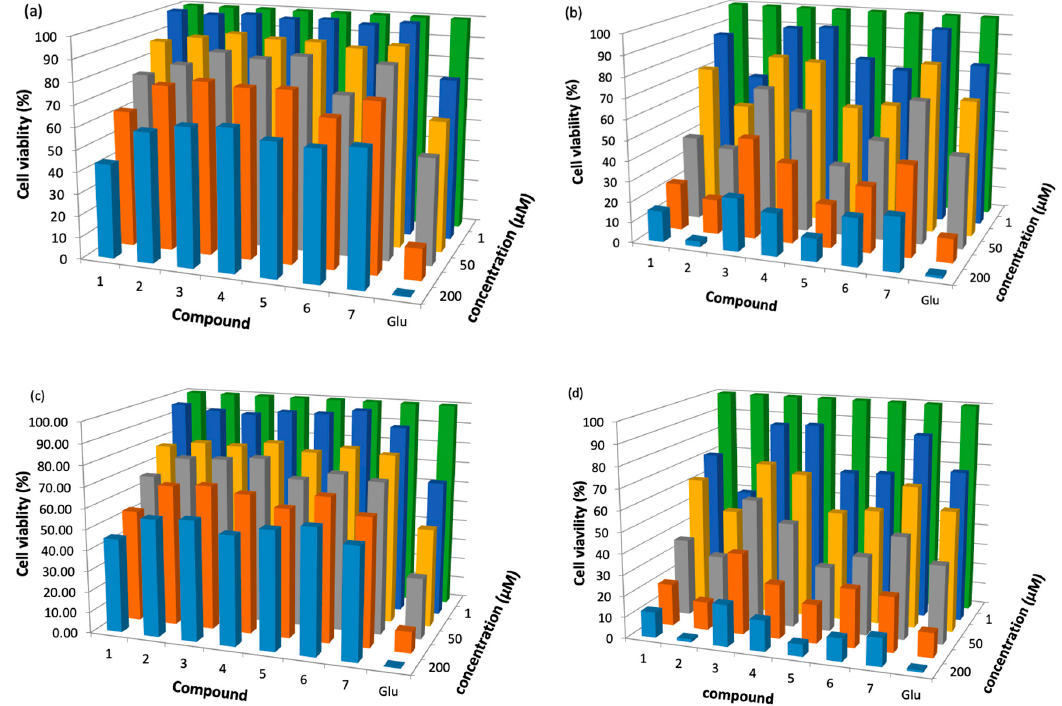
Figure 1. Parasite viability percentage results for compounds ( 1 – 7 ) with incubation periods of 24 h: against L. braziliensis ( a ) in the dark, ( b ) under light irradiation; against L. panamensis ( c ) in the dark; ( d ) under light irradiation.